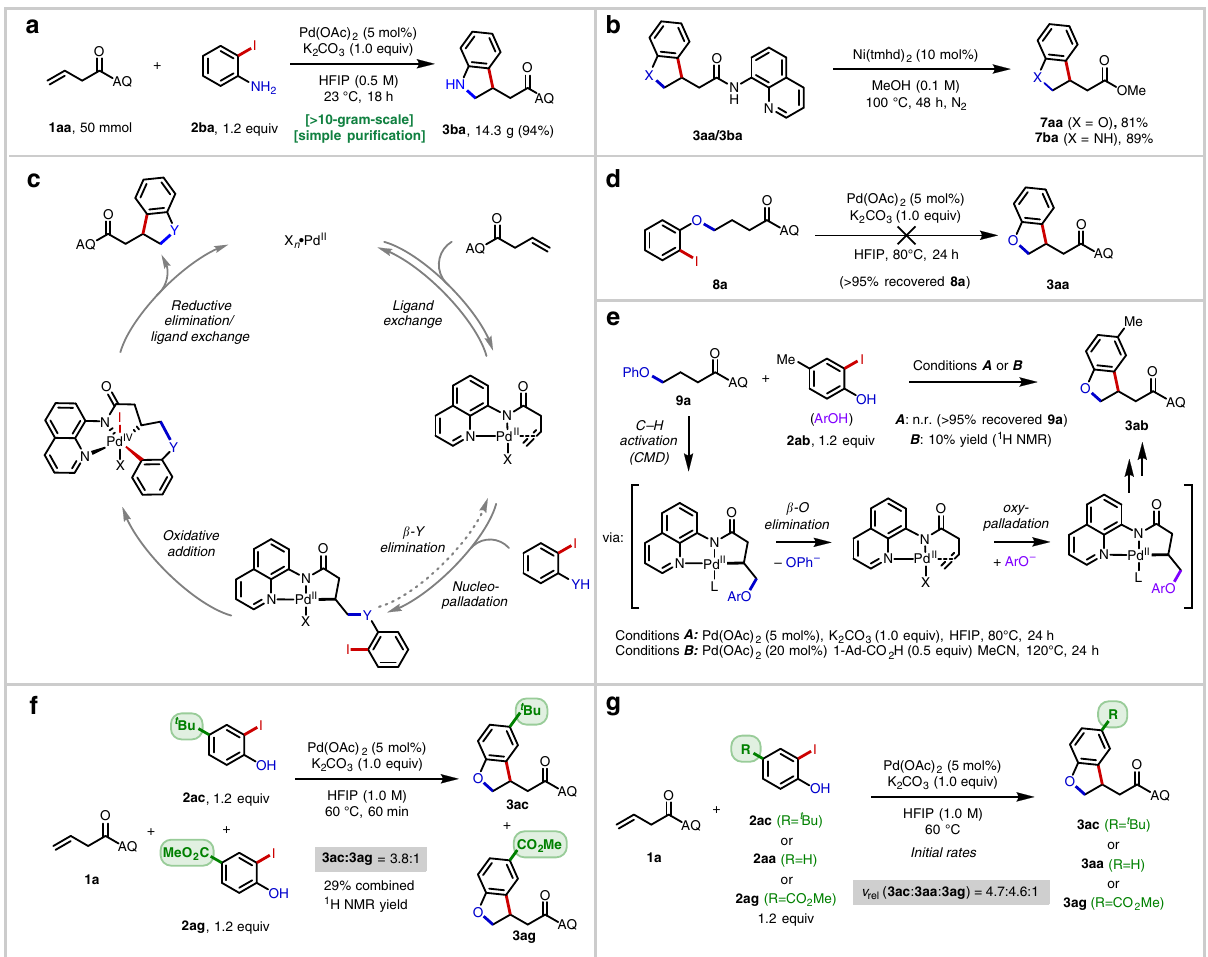
Fig. 2 Large-scale reaction, directing group removal and mechanistic studies. a 50 mmol-scale reaction. b Directing group removal. c Proposed mechanism. d Viability evaluation of an alternative pathway. e Evaluation of the potential reversibility of C(sp 3 ) – O bond formation. f Competition experiments. g Initial rate